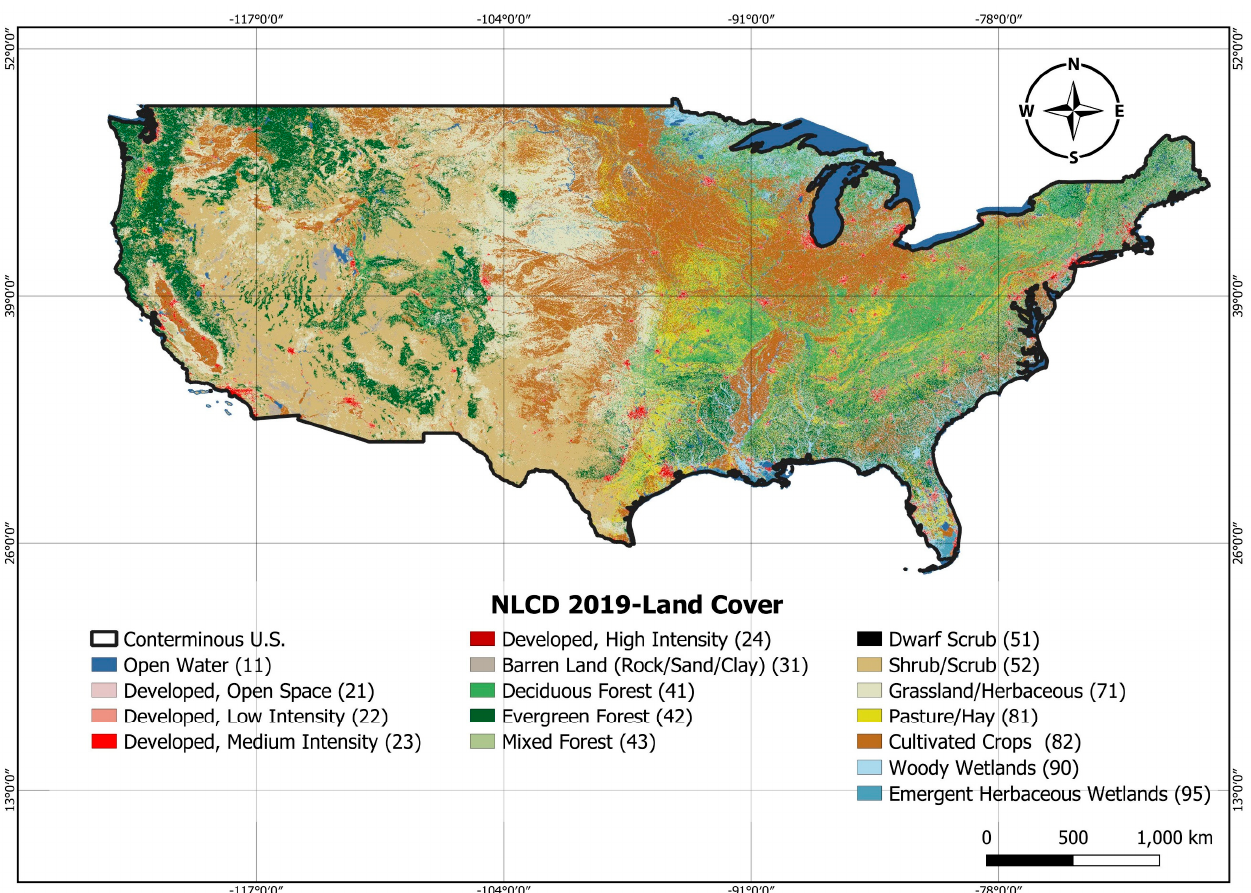
Figure 1. NLCD 2019 Classifications [31]. Landsat imagery for the NLCD 2019 dataset was processed based on an integrated training process that depends on different sources in addition to temporally and spatially integrated land-cover analysis and modelling [32].